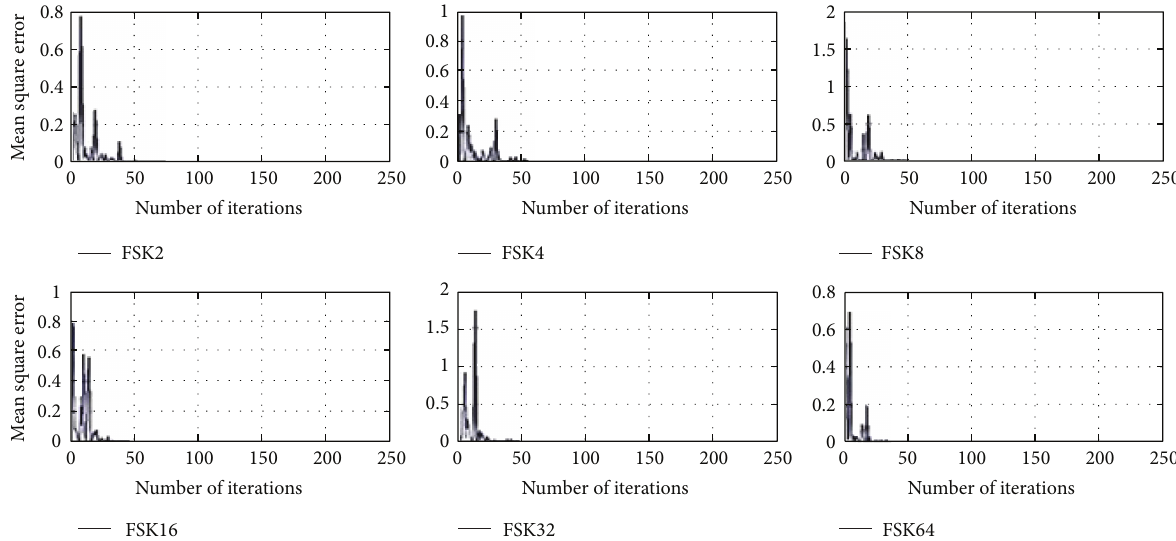
Figure 5: Training of Gabor filter parameters and weights for modulation classification in case of FSK modulation 2–64 for different number of iterations at SNR =